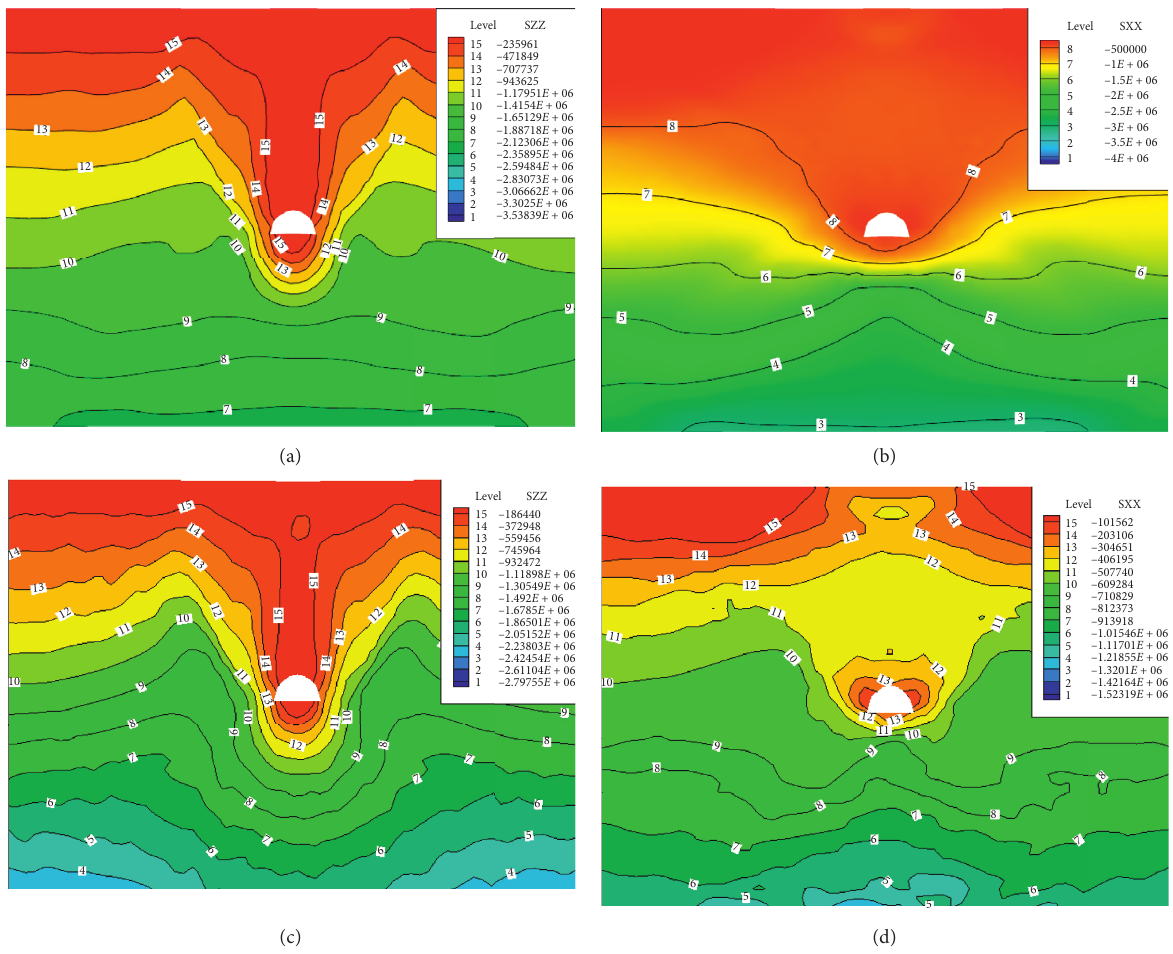
Figure 5: Stress contour of surrounding rock of tunnel under no support and original support. (a) Contour of ZZ-stress under no support. (b) Contour of XX-stress under no support. (c) Contour of ZZ-stress under original support. (d) Contour of XX-stress under original